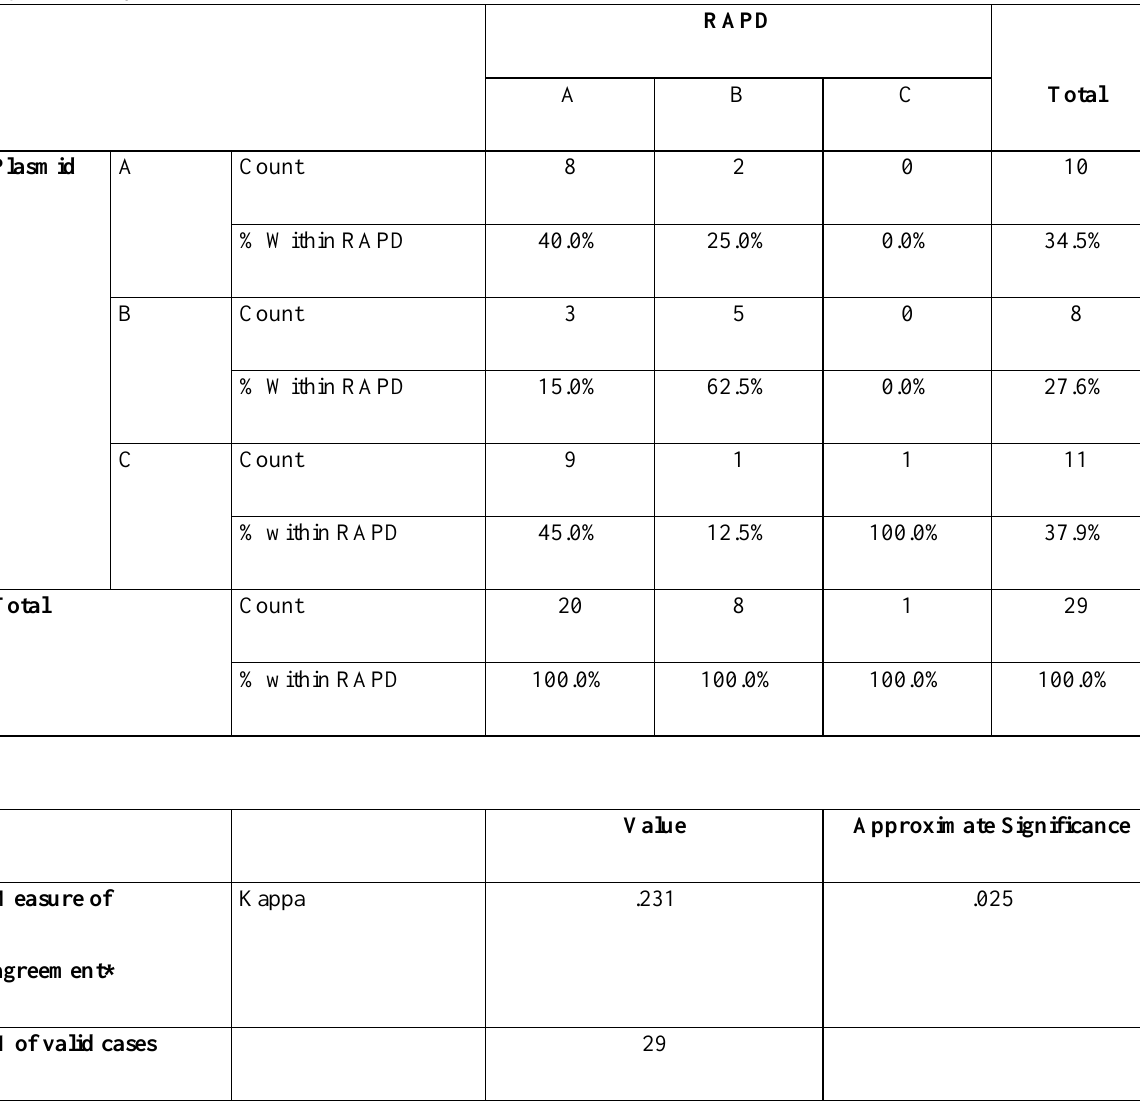
Table 1. Evaluation of the concordance between molecular clustering of the 30 K. pneumoniae isolates by plasmid profile analysis versus